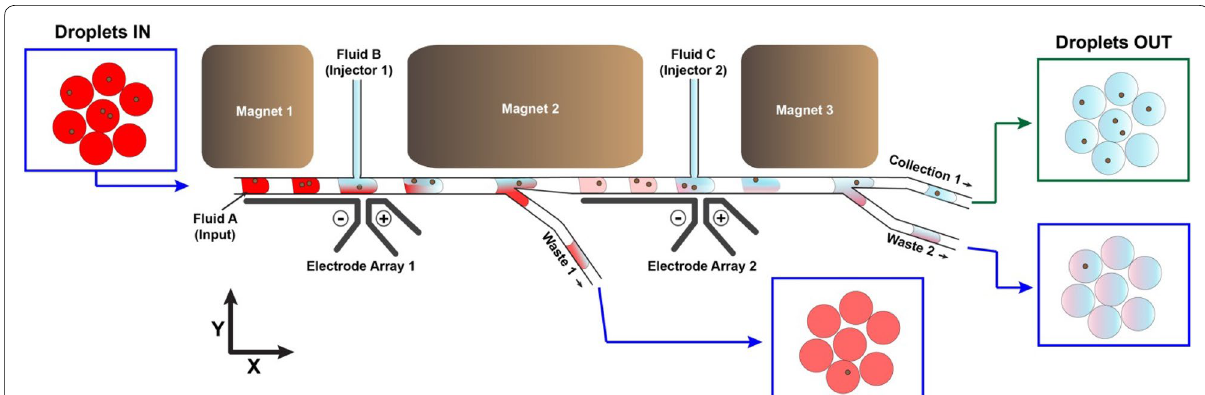
Fig. 1 Microfluidic droplet washing using serial inject and split strategy. Droplets IN contain the buffer to be diluted away (red) from magnetic particles contained within the droplets. Three magnets are placed on either side of wash buffer (light blue) injection channels. Splitting channels remove unwanted buffer from droplets after each injection cycle. The magnets direct the magnetic particles to the upper channel at each splitting junction. Droplets OUT (Collection 1) contain transferred magnetic microparticles exchanged into wash